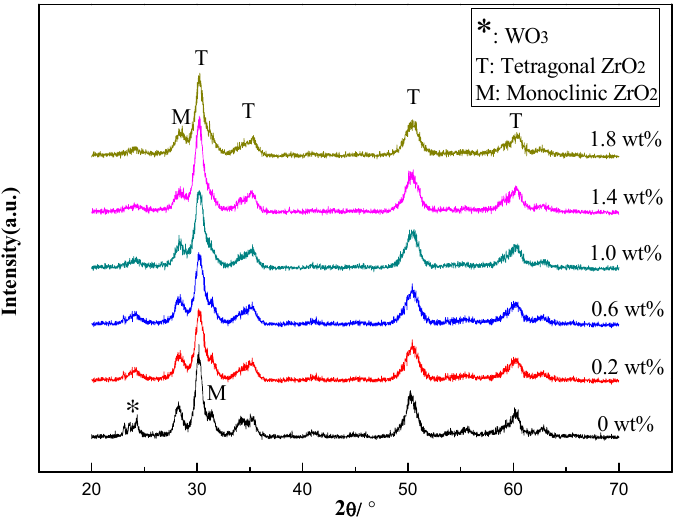
Figure 1. XRD patterns of the Cr-Pt/WZ catalyst with different Cr contents.